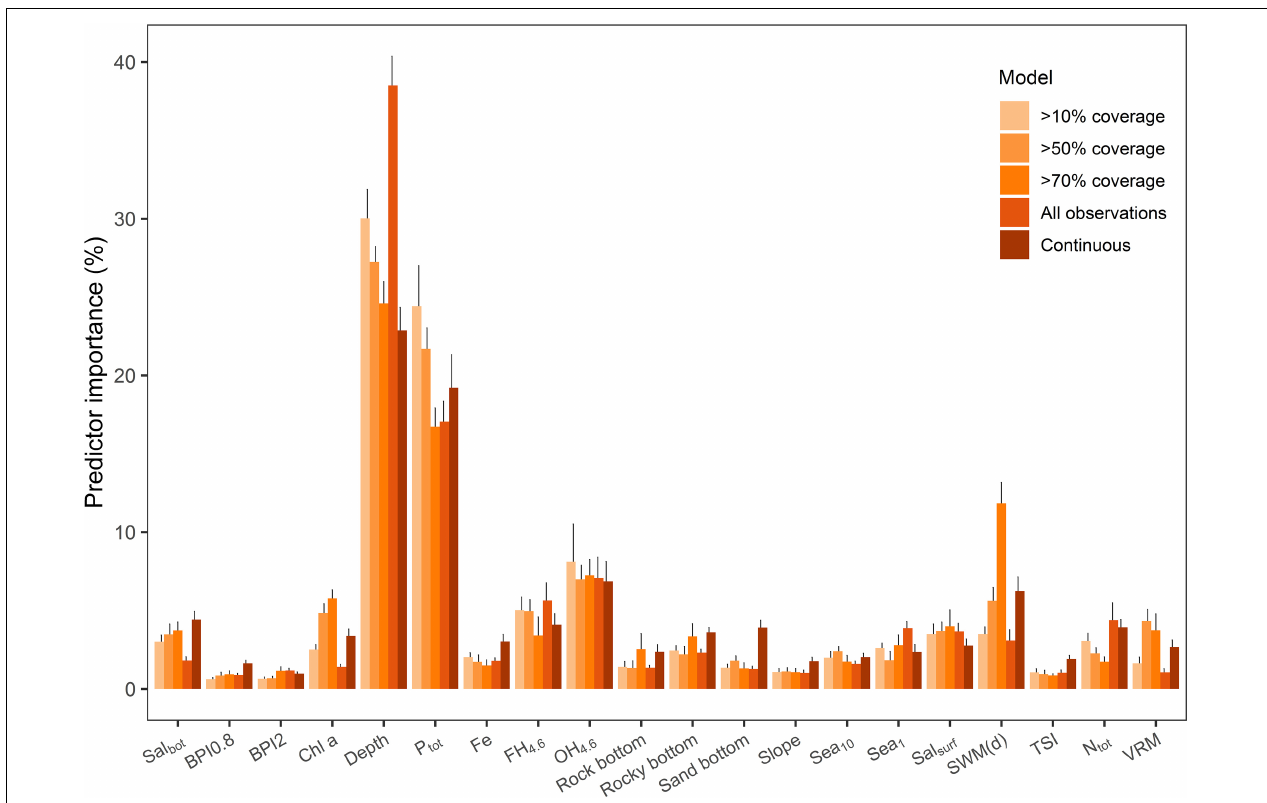
FIGURE 4 | Mean environmental predictor influence in different concretions models from the 10-fold cross-validation. Error bars present standard deviation of the runs for each model type. For abbreviations, cf. Table 1